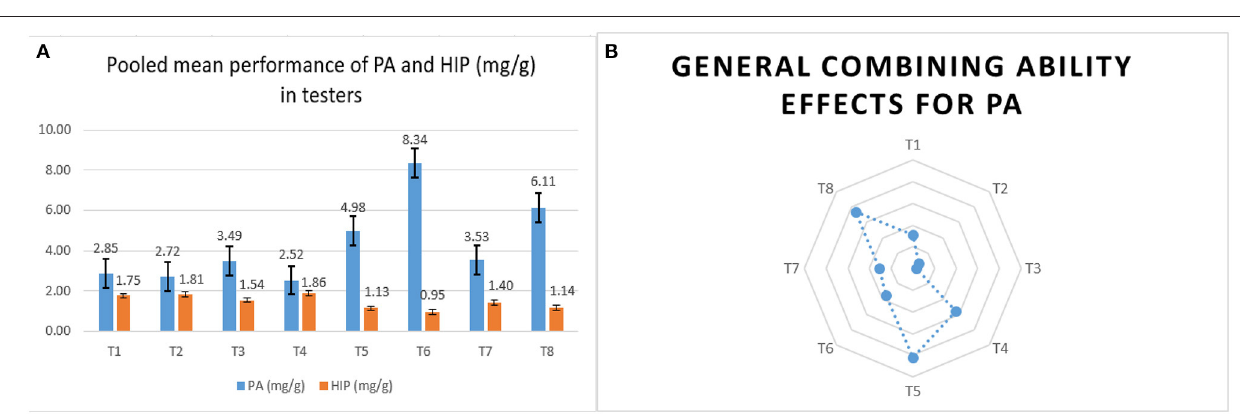
Frontiers in Plant Science |